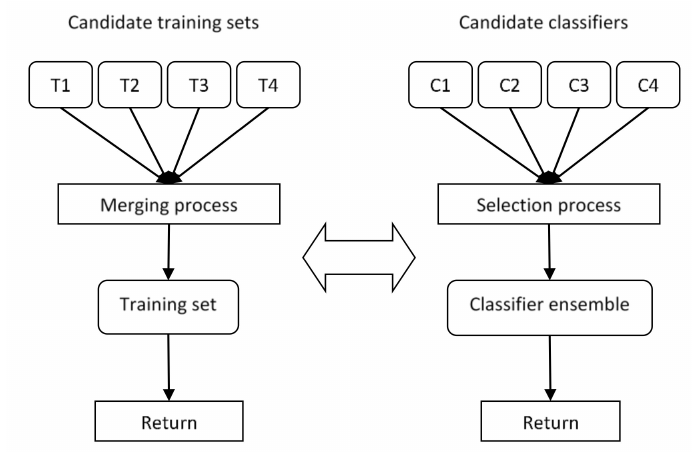
Figure 6. Resemblance between classifier ensemble selection (right) and candidate training set merging (left).